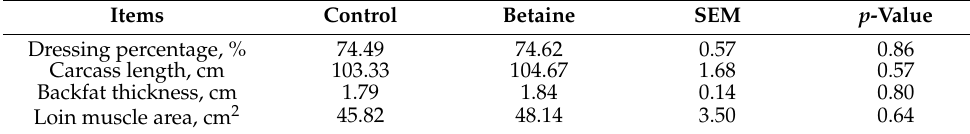
Table 2. Effects of betaine on the carcass characteristics in growing-finishing